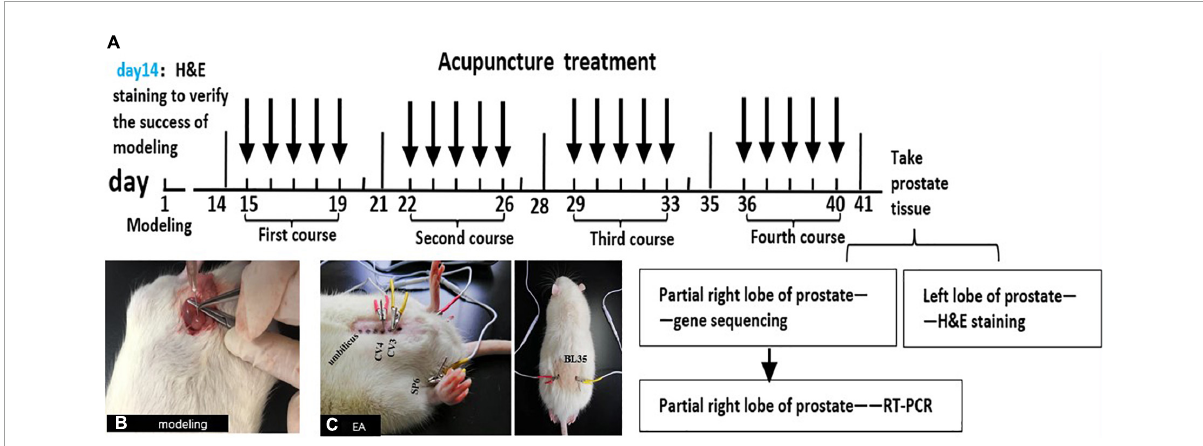
FIGURE1 The schematic diagram of this experiment. (A) The schematic diagram for methodologies. Male SD rats were injected with CFA into the ventral lobes of the prostate on both sides on the first day, and H&E staining was used to judge whether the model was successful or not on the 14th day. All groups were treated on the 15th day after modeling. Treatment once a day for 40 min, 5 days as a course of treatment, with 2 days of rest between the two courses, a total of 4 courses. At the end of the last course of treatment, the rats were anesthetized and sacrificed on the next day and take the prostates. The left lobe of the prostate was stained with H&E, and partial right lobes were analyzed with RNA-Seq technology. Then, combined with the results of RNA-Seq and modern research progress on the pain-related mechanism of CP/CPPS, the DEG and pain-related signal pathways were screened out. Finally, the key genes in the pathways were verified by qRT-PCR. (B) Injecting CFA into the prostate of rats to make CP/CPPS model. (C) Acupoint location and EA process in CP/CPPS rats. CV3(zhongji), CV4(guanyuan), SP6(sanyinjiao), and